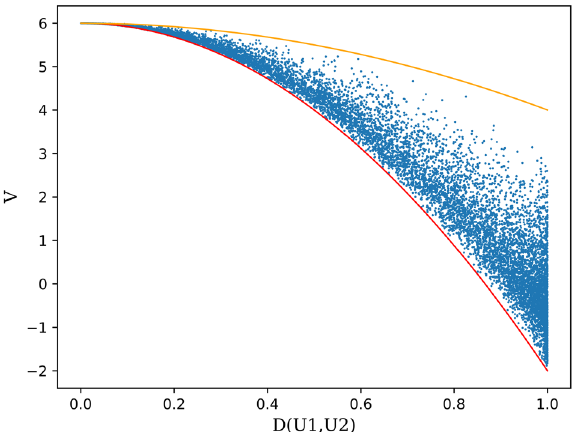
Fig. 1 The values of D ( U 1 , U 2 ) and V . Here d = 4, m = 2, and each blue point represents a pair of U 1 and U 2 that is randomly generated, on which the exact values of D ( U 1 , U 2 ) and V are given. The red and the orange solid lines are, respectively, the lower and the upper bounds provided by Theorem 2.